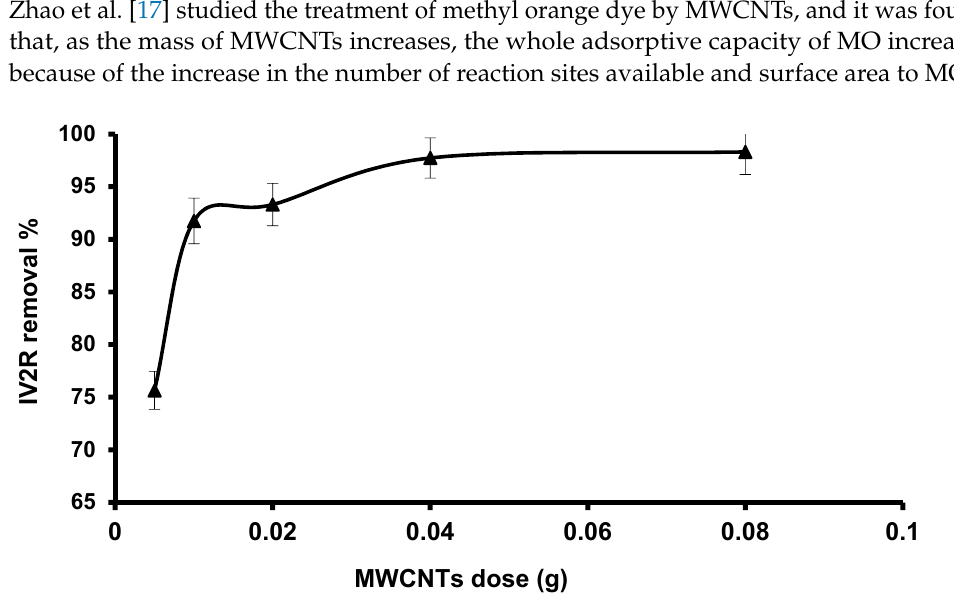
Figure 7. Influence of the MWCNT dose on the removal method.